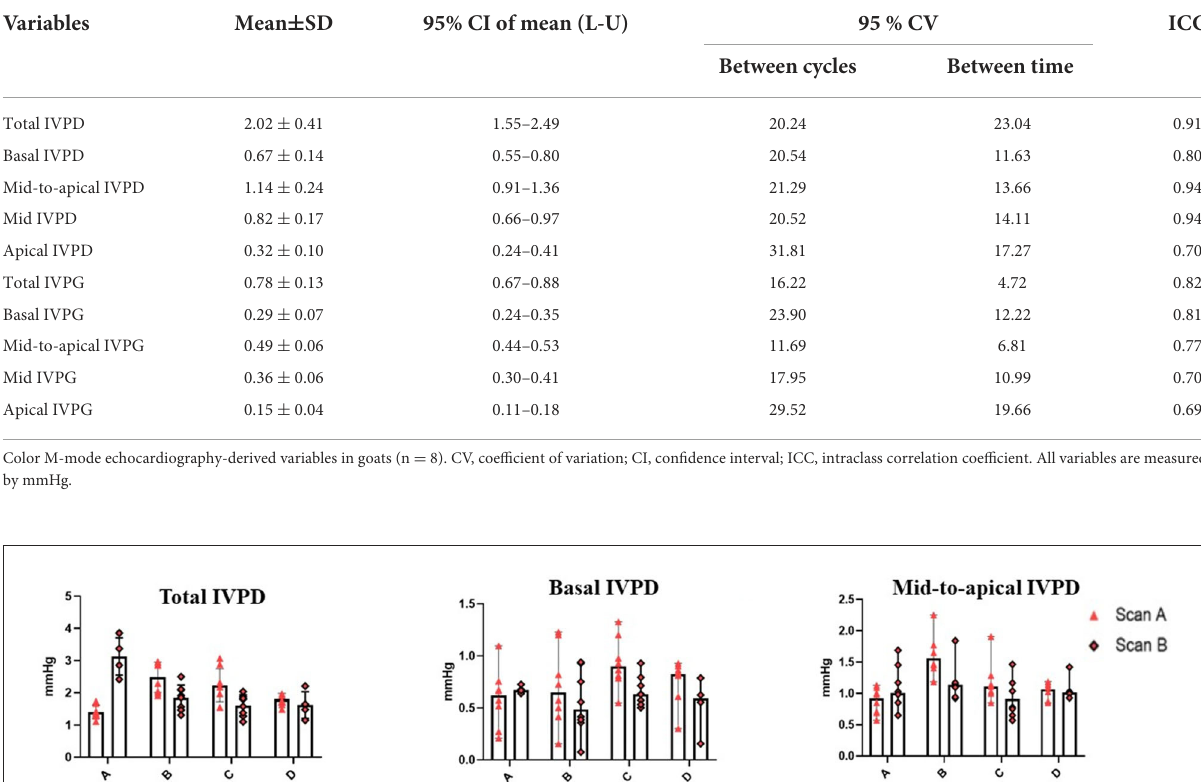
TABLE 2 Repeatability of color M-mode echocardiographic measurements in adult healthy male Shiba goats.